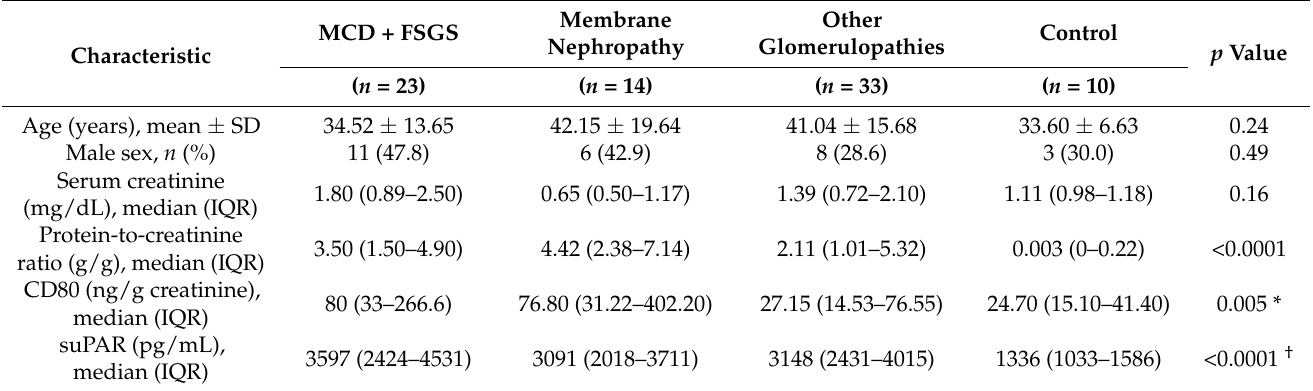
Table 2. Demographic characteristics and biomarker data at diagnosis in the combined Minimal Change Disease + Focal Segmental Glomerulosclerosis group, in comparison with the membranous nephropathy, other glomerulopathies and control groups.